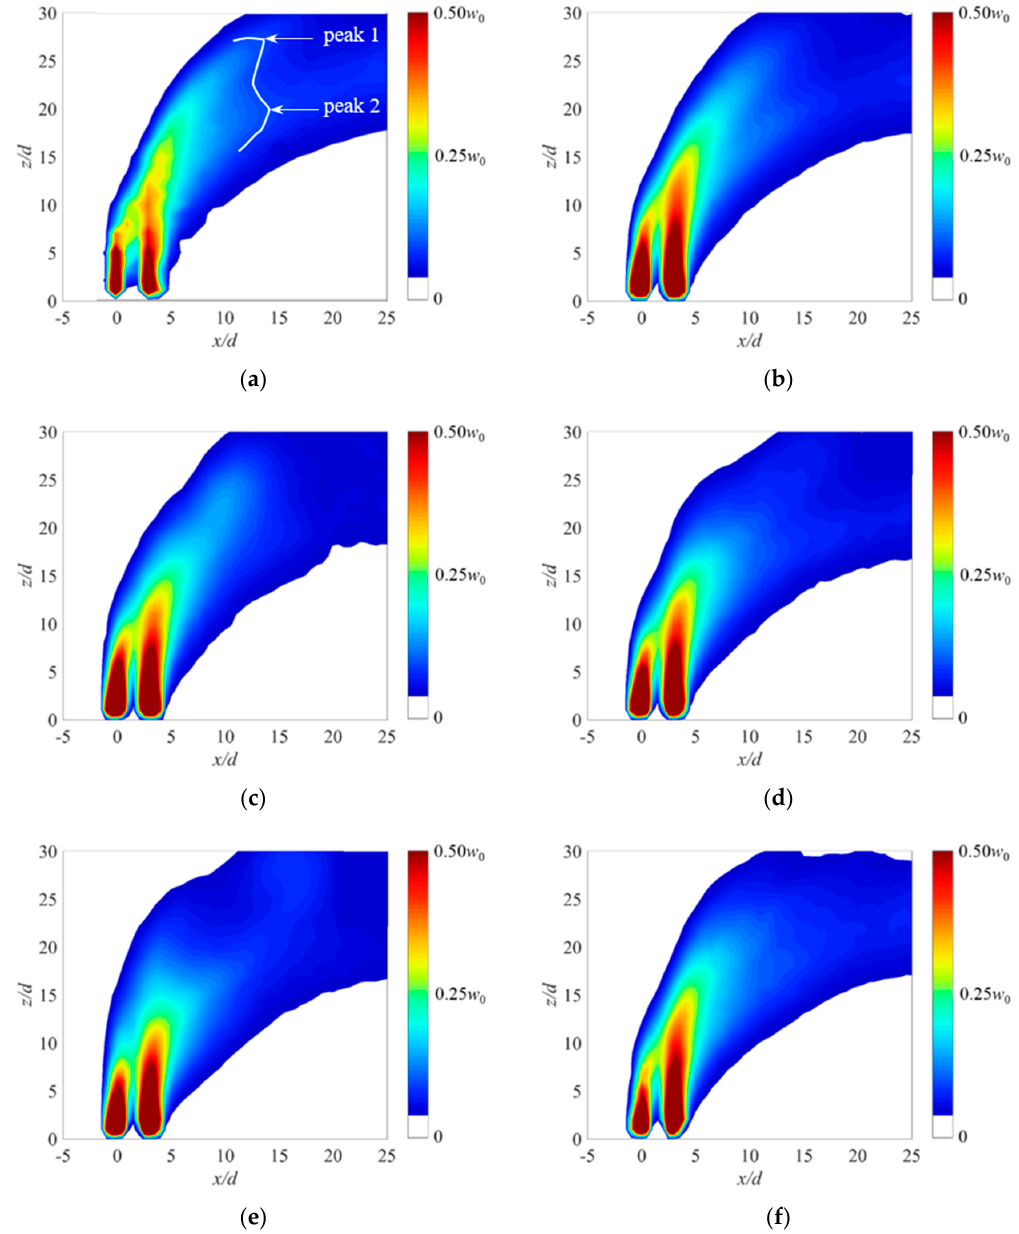
Figure 8. Time-averaged vertical velocity distribution of the jets in the wavy cross-flow environment: ( a ) Case A0; ( b ) Case A1; ( c ) Case A2; ( d ) Case A3; ( e ) Case A4; ( f ) Case